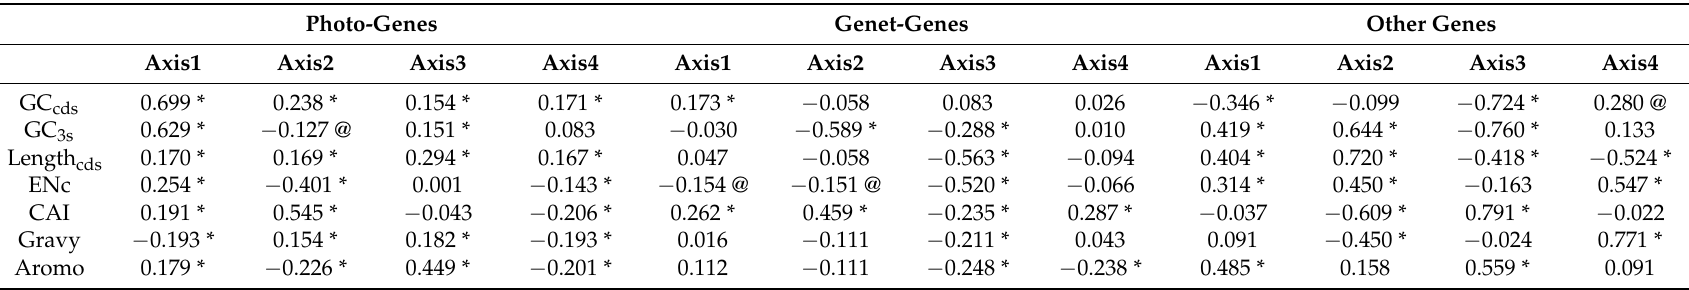
Table 4. Correlation coefficients between the four axes (generated using the correspondence-analysis) and codon usage indices in three gene categories (Photo-, Genet-, and Other-genes) of Solanum chloroplast genomes. For Photo-genes, Axis1 to Axis4 accounted for 13.07%, 11.29%, 8.47%, and 8.12%, respectively, of their total variation. For Genet-genes, Axis1 to Axis4 accounted for 16.31%, 13.32%, 11.72%, and 10.34%, respectively, of their total variation. For Other genes, Axis1 to Axis4 accounted for 46.26%, 31.35%, 12.51%, and 4.58%, respectively, of their total